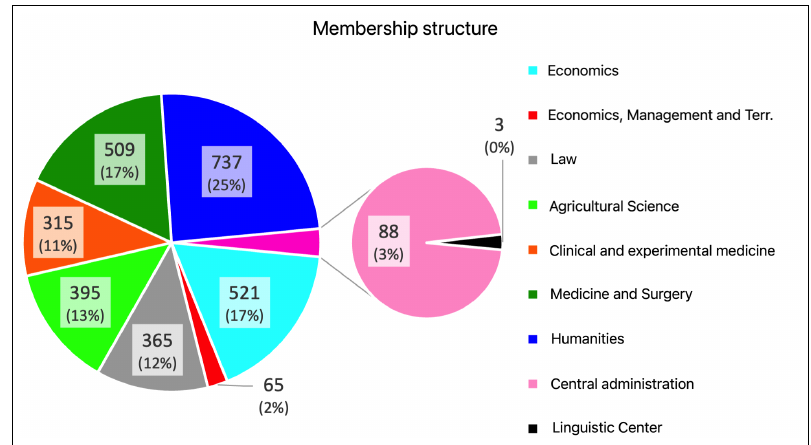
Figure 9. Respondents’ membership structures.